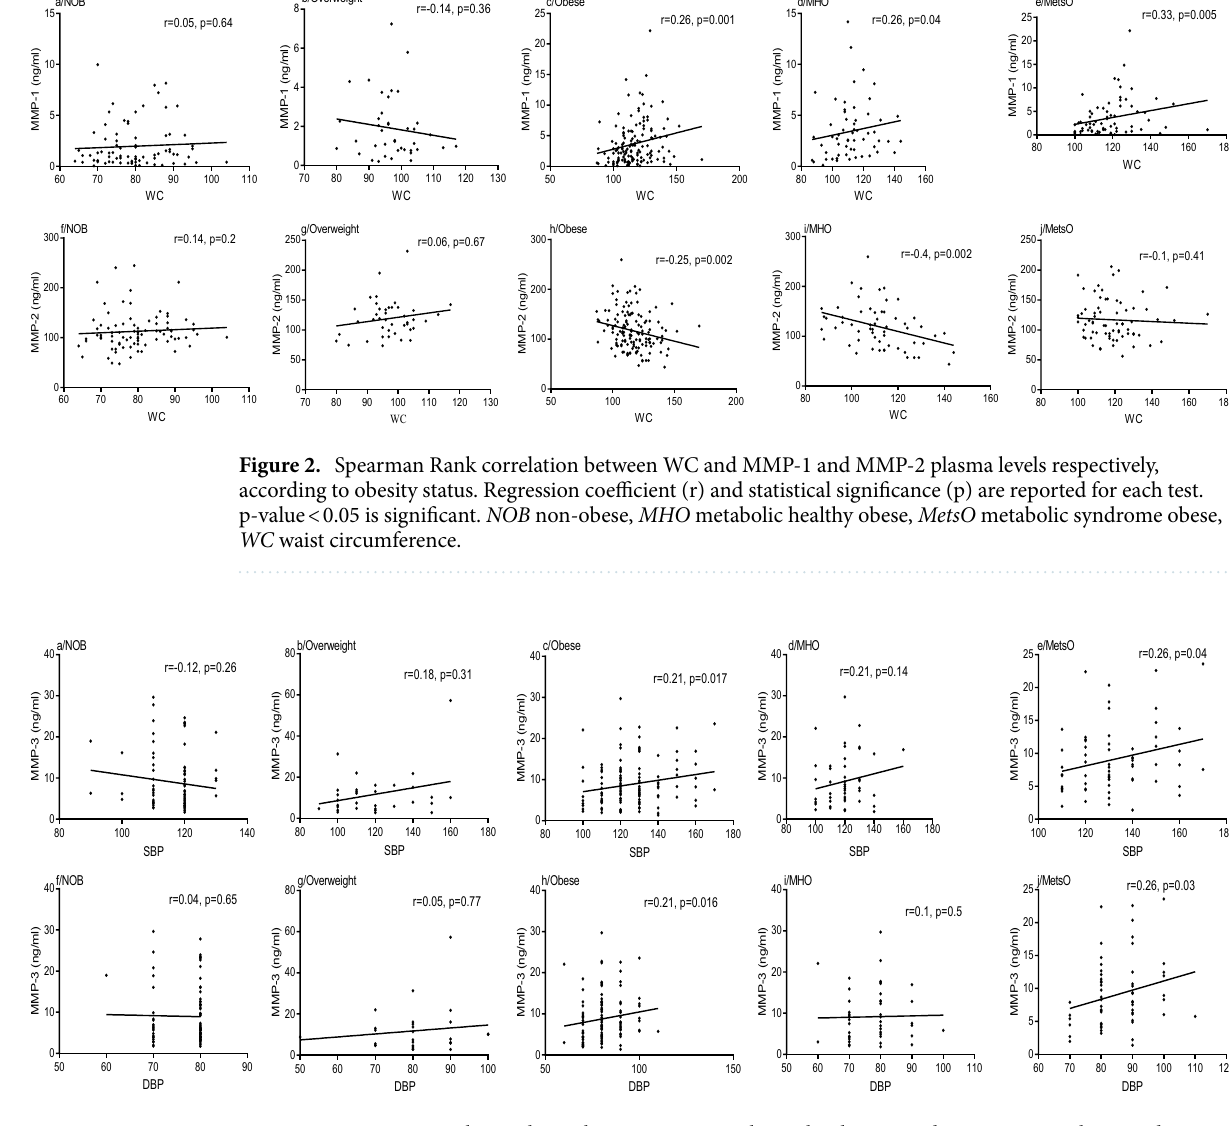
Figure 3. Spearman Rank correlation between MMP-3 plasma levels, SBP and DBP respectively, according to obesity status. Regression coefficient (r) and statistical significance (p) are reported for each test. p-value < 0.05